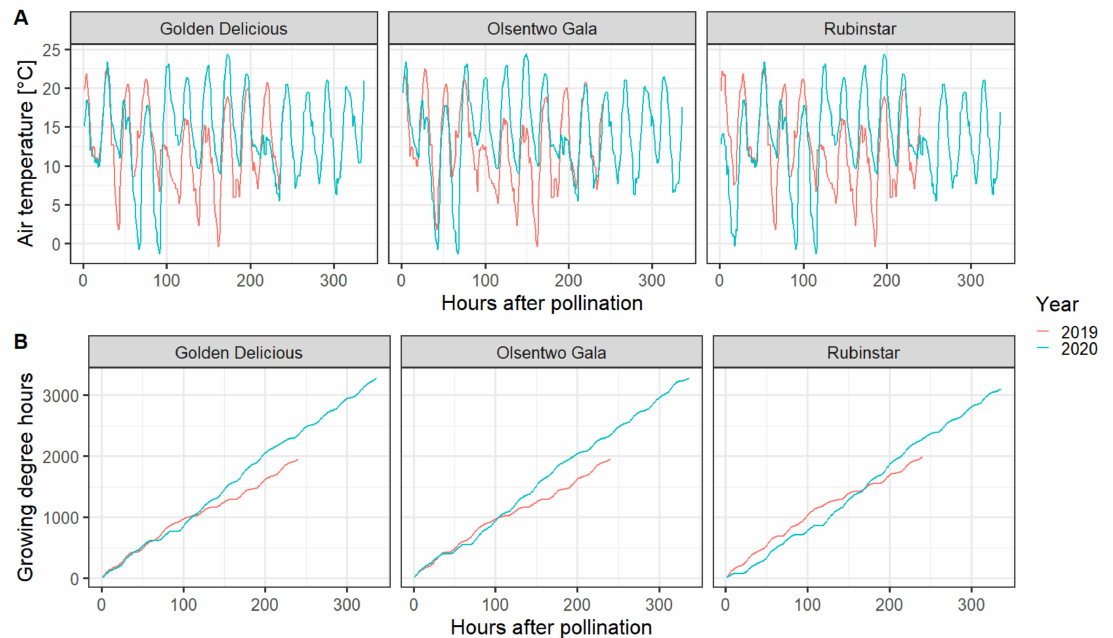
Figure 2. Hourly temperature ( A ) and cumulative growing degree hours with a base temperature of 4.5 ◦ C ( B ) during the experimental period in 2019 (red line) and 2020 (blue line). Data were acquired from the WSU AgWeatherNet website (https://weather.wsu.edu/, accessed on 31 July